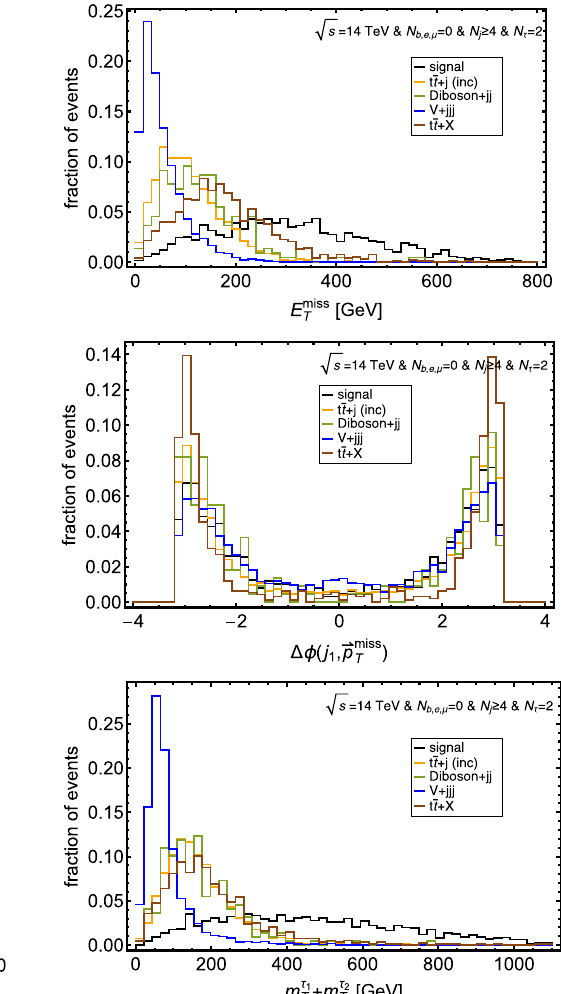
significance (medium left panel), the azimuthal right panel), the E miss T ) between the leading jet and the p miss angle difference (cid:7)φ ( j 1 , p miss T (medium right panel), the effective mass m eff (lower left panel), and the (upper T sum of the transverse masses of the τ h leptons (lower right